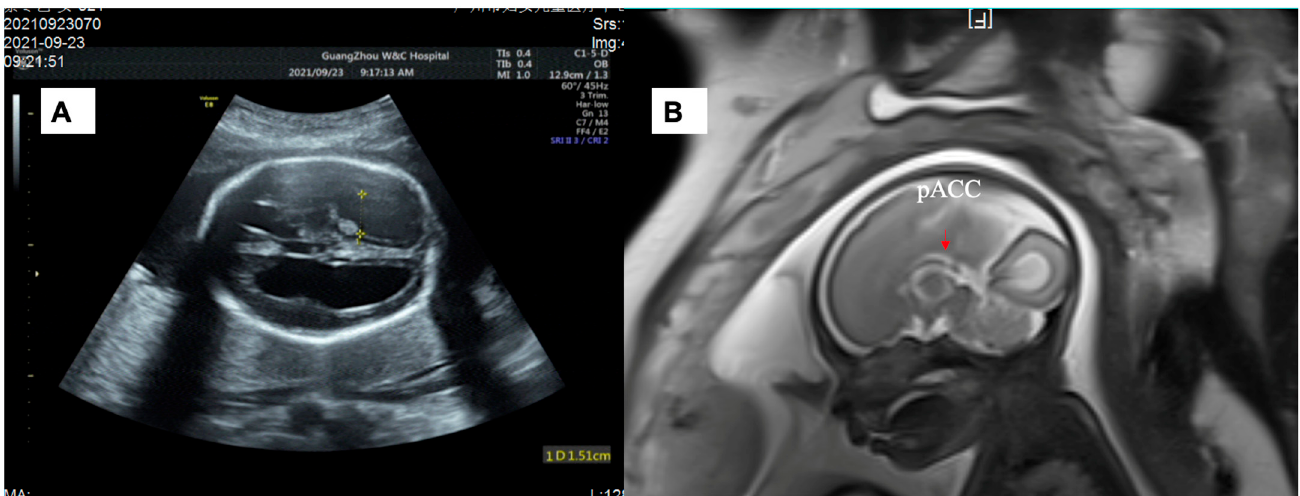
Figure 1. ( A ) Sonographic images of Fetus 1 showing lateral ventriculomegaly (left: 15.1 mm; right: 15.5 mm) at the 26-week scan. ( B ) Brain MRI images showing absence of the splenium of corpus